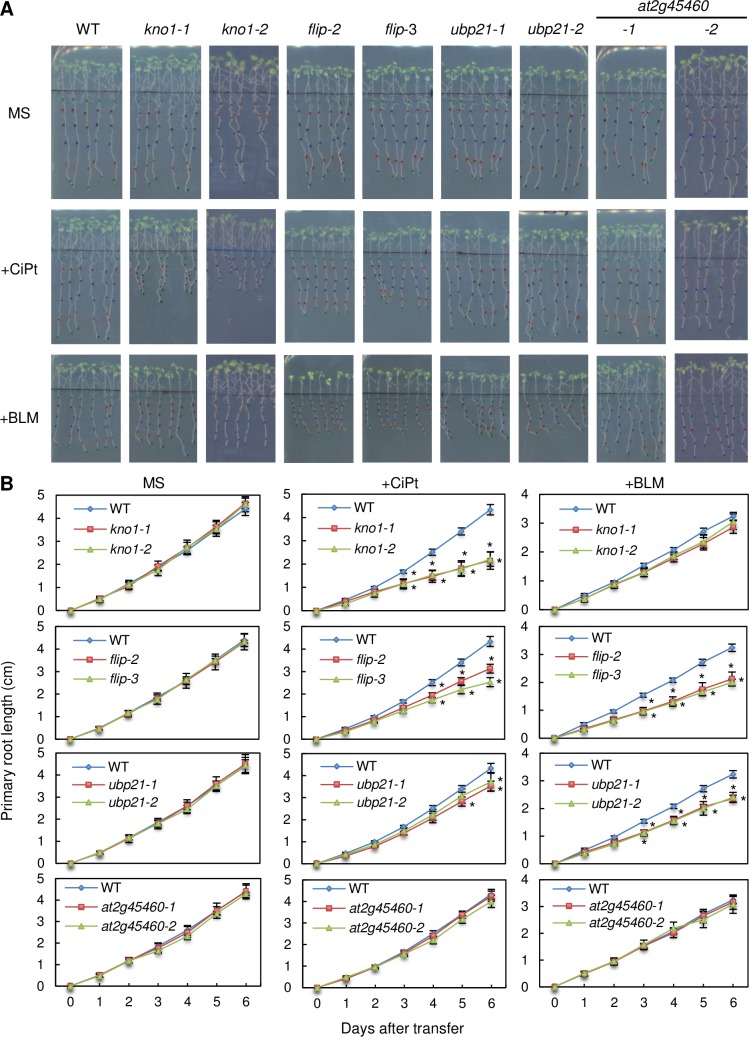
Root growth analysis on DNA damaging drugs.Root growth of the wildtype and kno1 (at3g20490), flip (at1g04650), ubp21 (at5g46740) and at2G45460, represented by 2 different mutant alleles each, on 20 μM cisplatin (CiPt) and 0.3 μg/ml bleomycin (BLM). (A) Pictures after 6 days of growth. (B) Root length per day. Statistically significant differences to the wildtype are indicated by asterisks (p < 0.05).